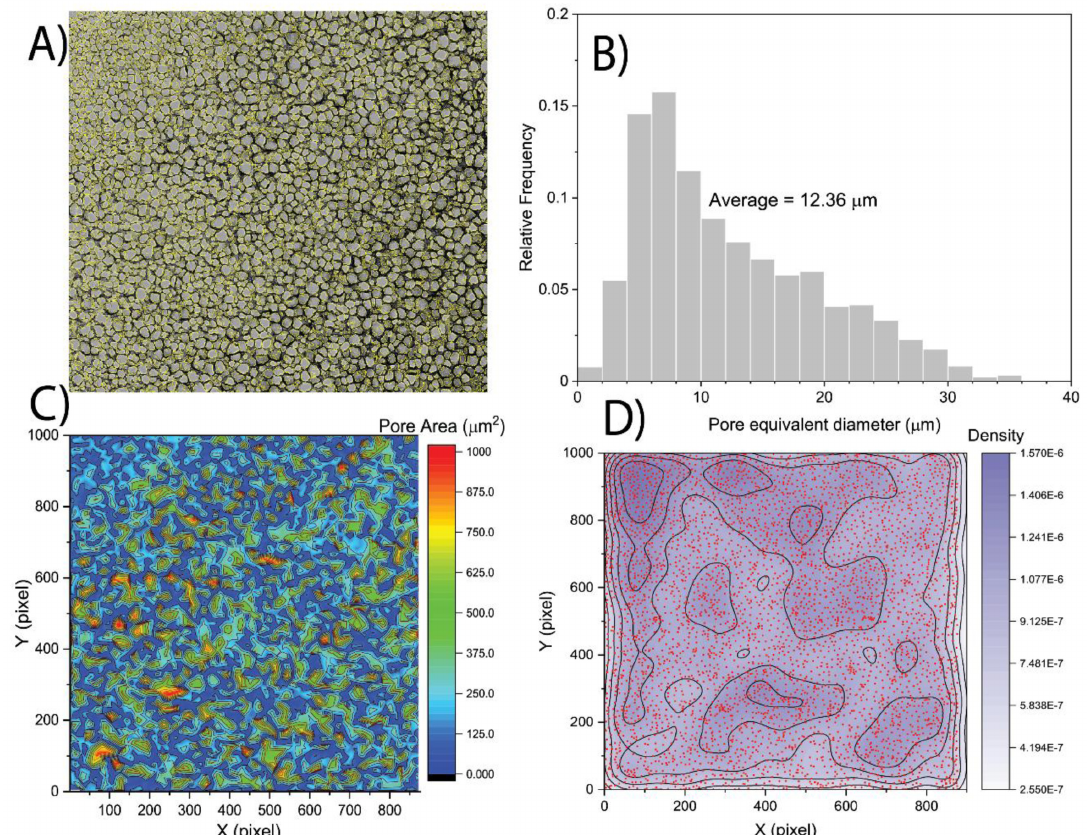
Figure 2. Porosity and heterogeneity analysis of glycidyl methacrylate hydrogel crosslinked with 0.3 mol% di(ethylene glycol) dimethacrylate. A ) Detected pores of cryo-SEM micrographs. B ) Pore size distribution. C ) Spatial contour maps of pore area. D ) Kernel density estimation dot plots demonstrating the spatial density of detected pores. Data adapted from Kaberova et al. 8 with